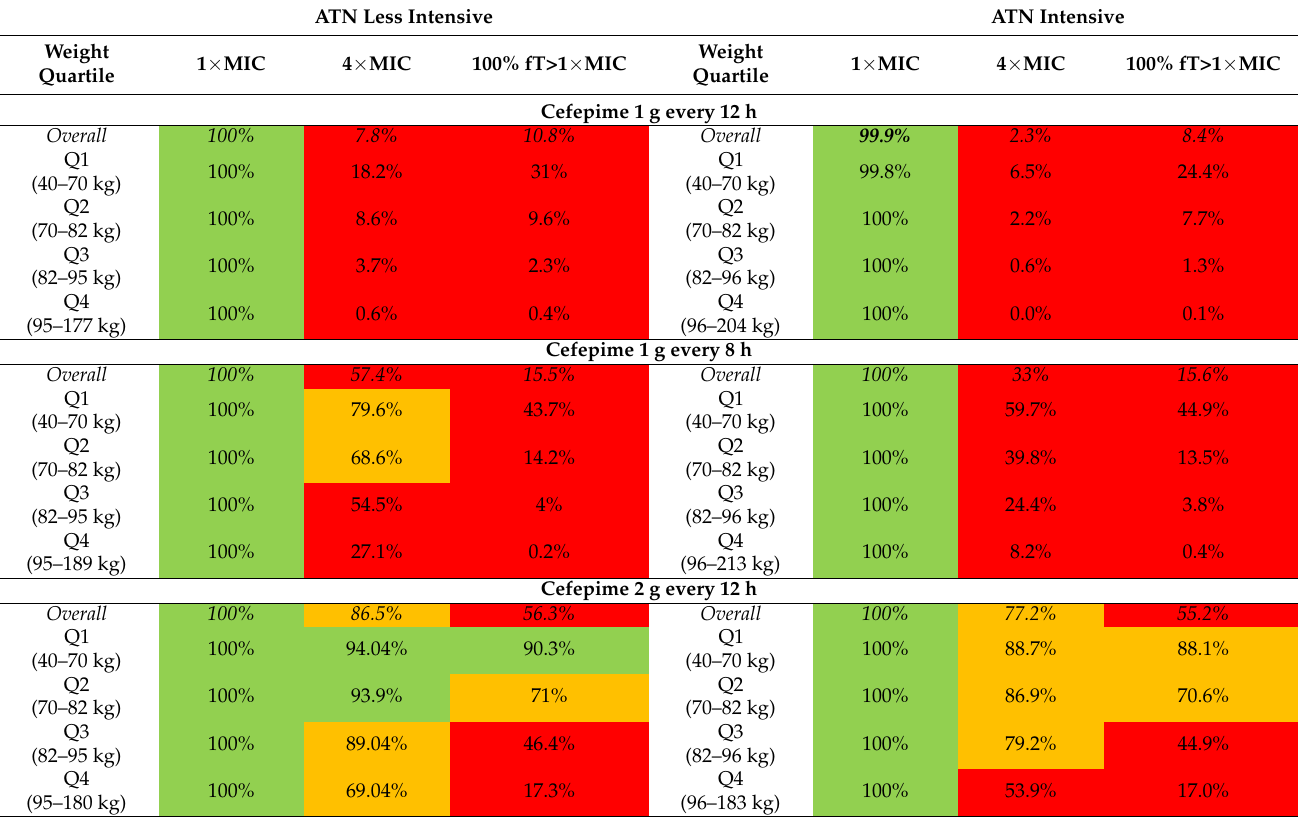
Table 1. Probability of target attainment comparison among weight quartiles for key beta-lactams used in the ATN trial: Cefepime, ceftazidime, piperacillin, and